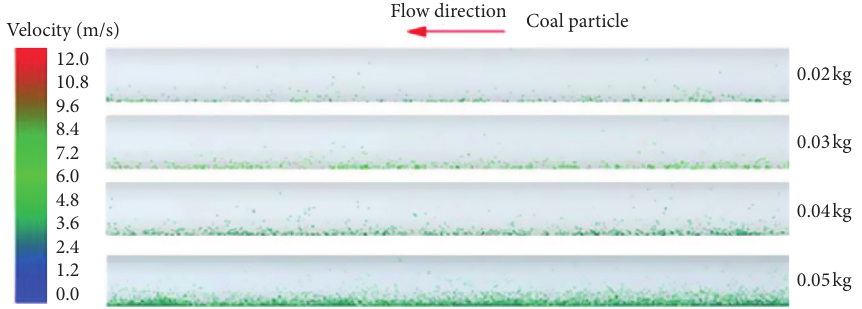
Figure 7: The coal-gas flow characteristic in drilling rod at 4.5 ∼ 5.0m under gas velocity 15m/s ( t � 3s).